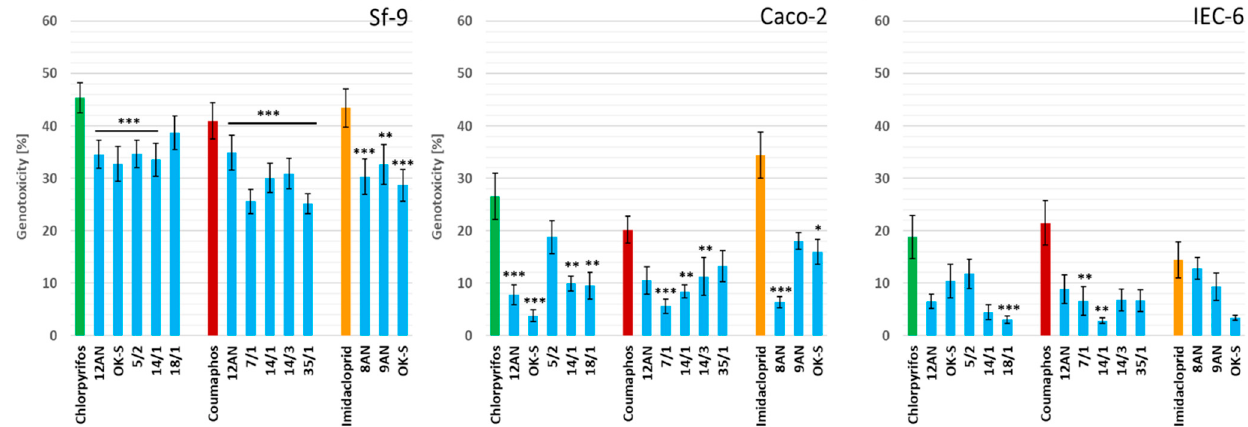
Figure 3. Decrease in the genotoxicity of chlorpyrifos, coumaphos, and imidacloprid after 24 h incubation with lactic acid bacteria (LAB) strains expressed as the mean percentage of DNA in the comet tail in the alkaline comet assay. Fifty cells were analyzed for each treatment. Results are presented as mean ± standard error of the mean (S.E.M.). Statistical significance was calculated versus positive control (appropriate pesticide standard), * p ≤ 0.1, ** p ≤ 0.05, *** p ≤ 0.01.